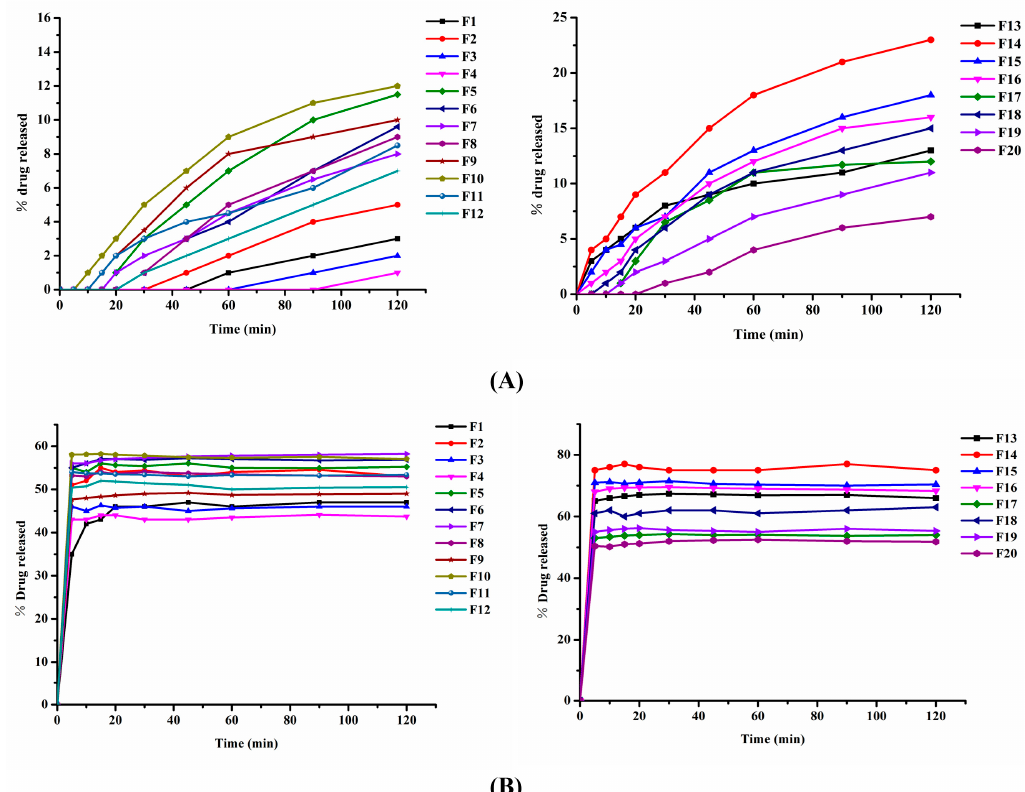
Figure 3. Dissolution of several formulations with different drug/alkalizer/polymer ratios. ( A ) Dissolution of F1–F20 in pH 1.2 HCl ( n = 6). ( B ) Dissolution of F1–F20 in pH 6.8 buffer ( n = 6).